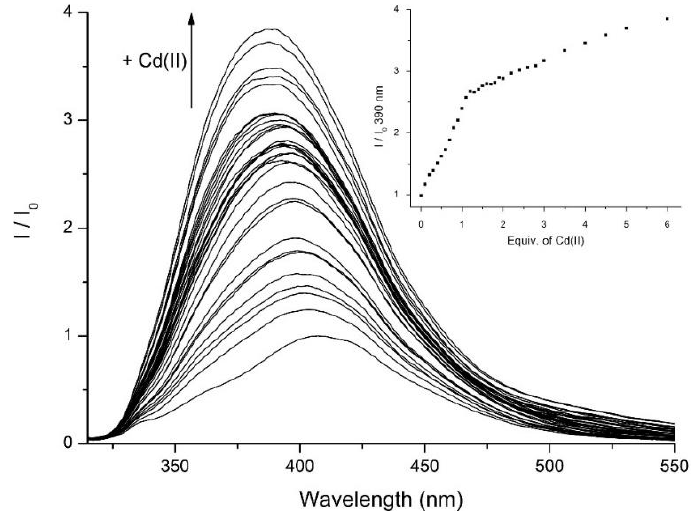
Figure 9. Variation of the fluorescence emission spectra of L by adding Cd(ClO 4 ) 2 registered in an ACN–aqueous HEPES pH 7.4, 4:1 v/v solvent mixture. Inset: trend of emission intensity of L